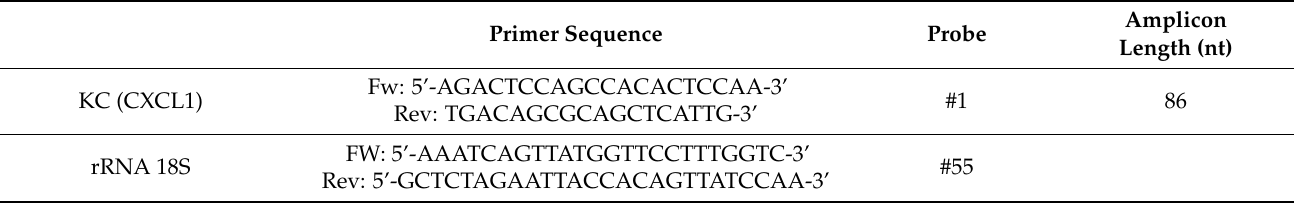
Table 3. Primers Sequence and Probe Catalog